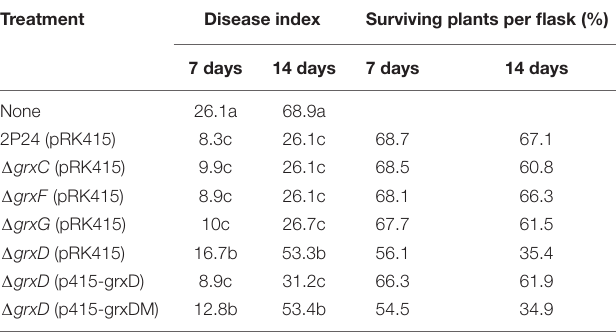
TABLE 1 | Contributionof grx genes in strain 2P24 to the suppression of tomato bacterial wilt caused by Ralstonia solanacearum